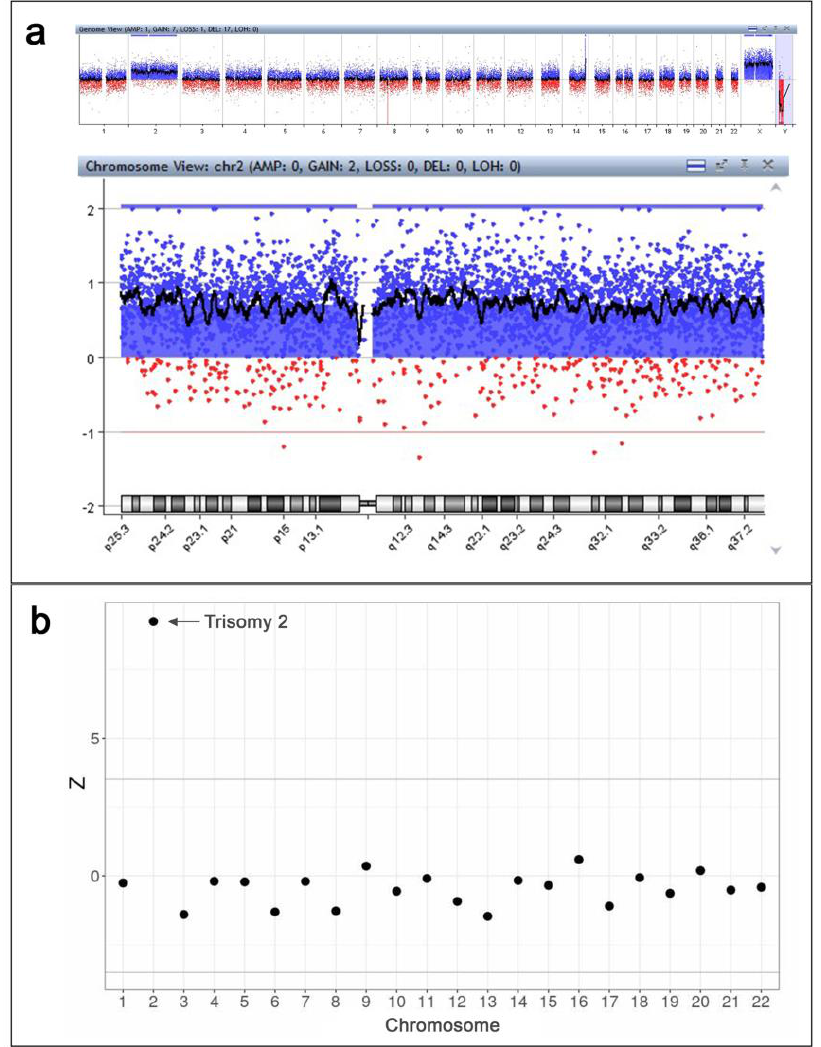
Figure 2. The results of invasive and non-invasive prenatal genetic investigations. ( a ) The results of CVS analysis by aCGH (Agilent CytoGenomics v.5.0.2.5): a complete trisomy 2 and a small